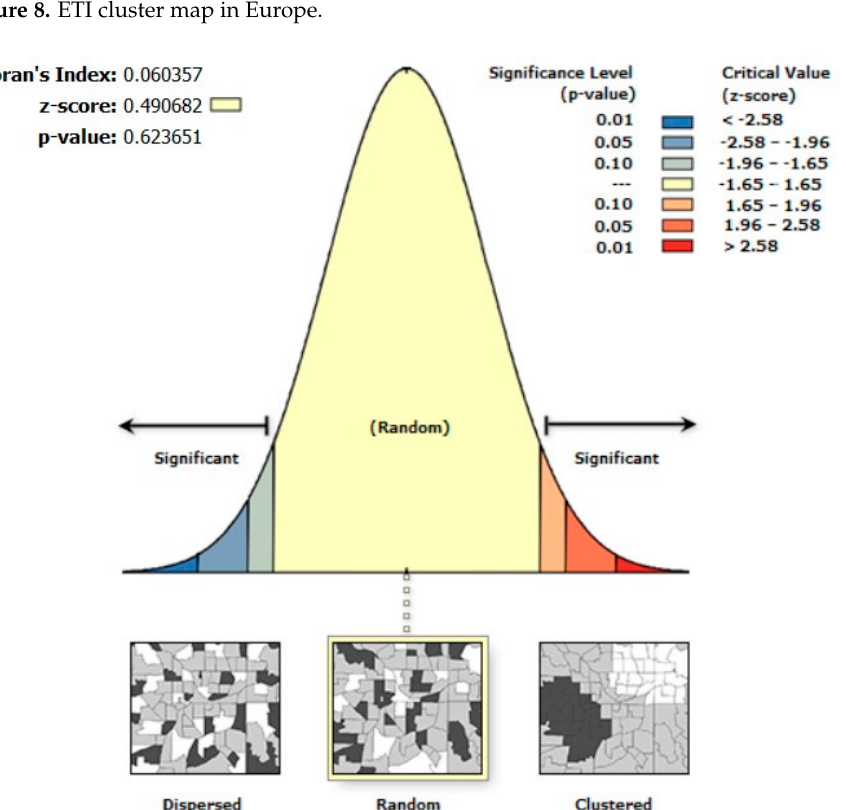
Figure 9. Moran’s I distribution for ETI in North and South America.